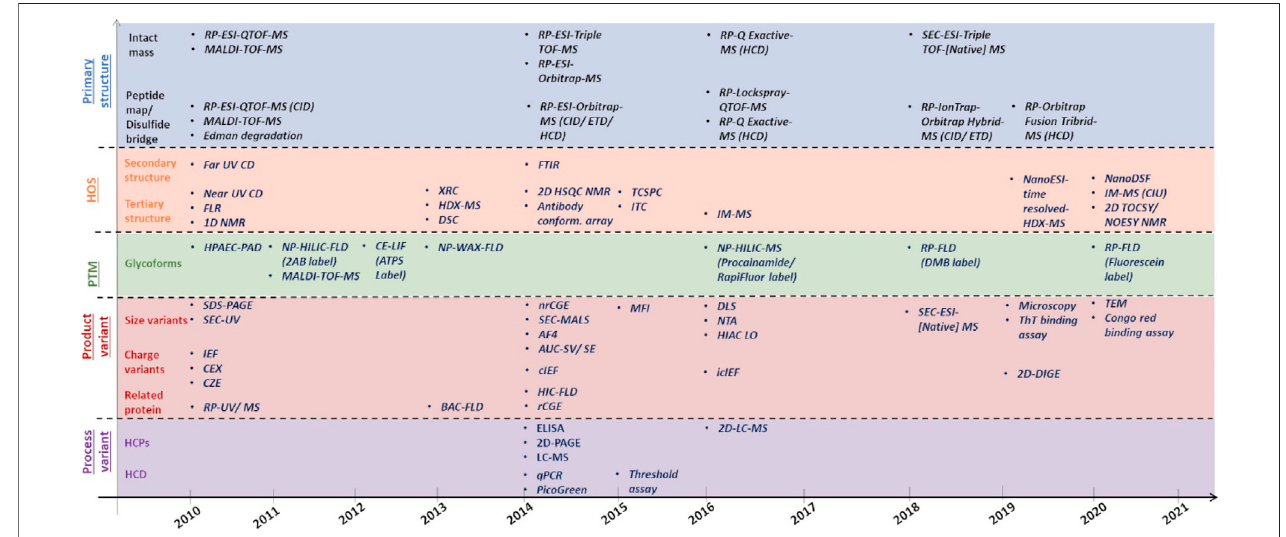
FIGURE 4 | Evolutionary timeline of analytical platforms used for different CQAs i.e., primary structure, HOS, glycosylation, product-related and process-related variant with respect to analytical biosimilarity